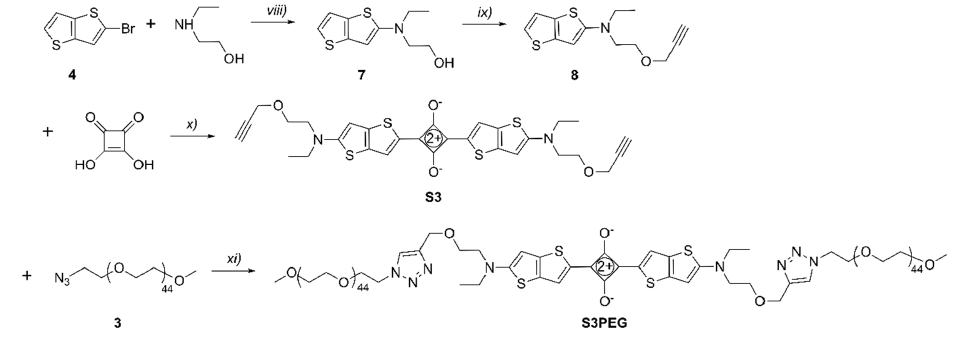
Figure 2. Comparison of partial 1 H-NMR spectra for separate samples of free S3 , M1 ⊃ S3 , and free M1 in CDCl 3 . Atom labels are provided in Scheme 2. Red and blue lines indicate major changes in chemical shifts upon complexation. * designates NMR signals for the minor M1 ⊃ S3 complex with encapsulated S3 in a cis conformation (trans/cis ratio for encapsulated S3 is >10:1). See Scheme 2 for atom labels which are numbers (for S3 ) and letters (for M1 ).